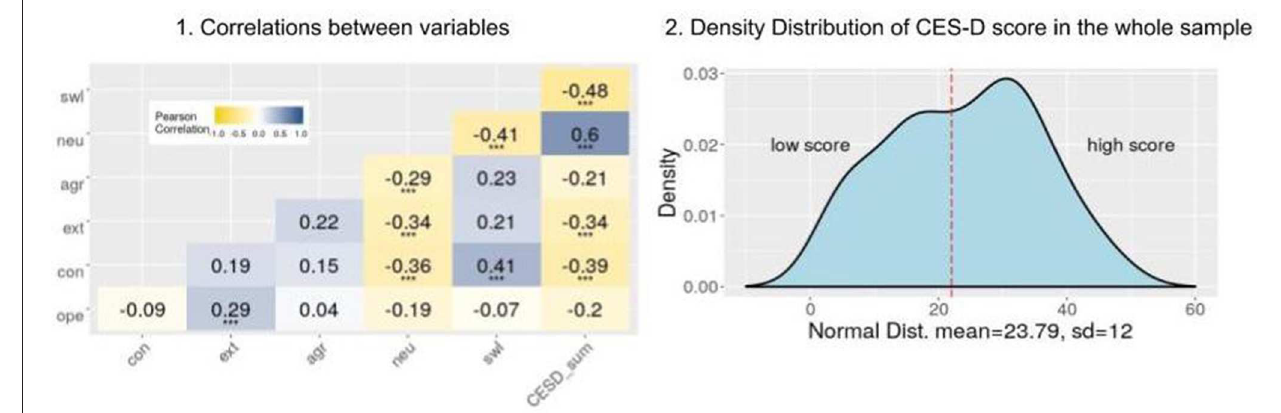
FIGURE 1 | Basic statistics for personality trait scores, SWL and CES-D scores. Plot 1 is a heat map of correlations between personality traits, SWL, and CES-D scores ( ∗∗∗ p < 0.001). Plot 2 illustrates the distribution of the CES-score in the entire sample ( N = 70). The dotted line indicates the cutoff score of